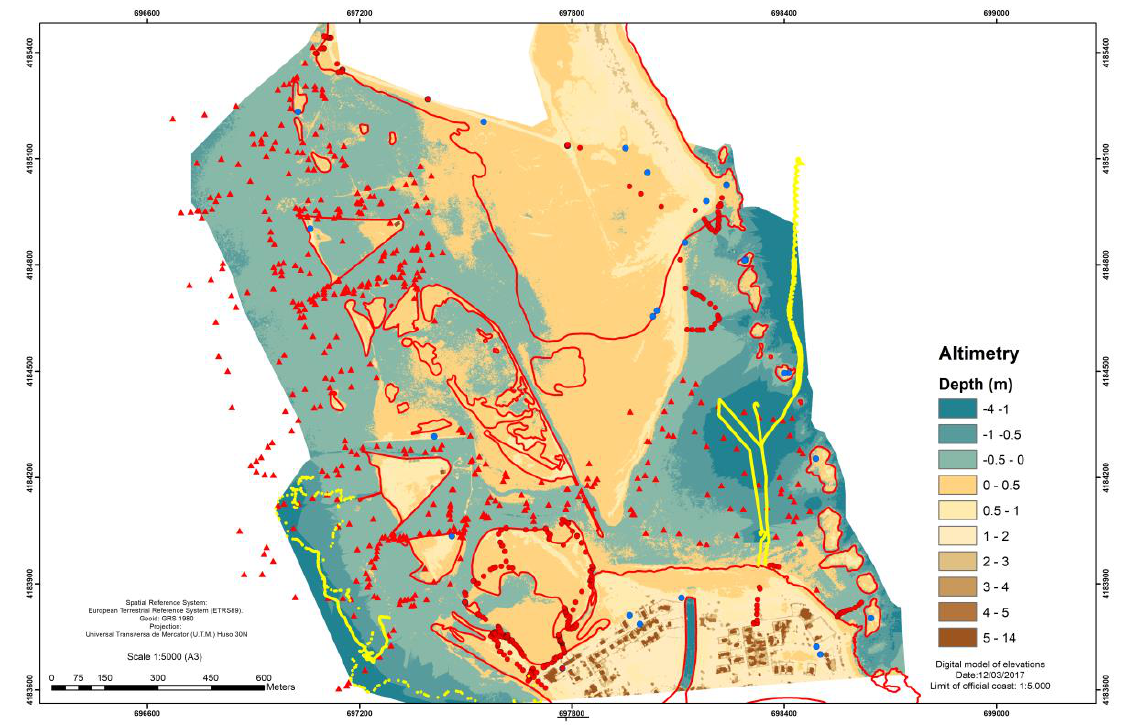
Figure 9. Water depth estimated on 13 March 2017, using an USV, Pleiades, and ground data (red and blue points correspond to GPS data, while yellow points correspond to USV data). The red line corresponds to the coast in 1999.